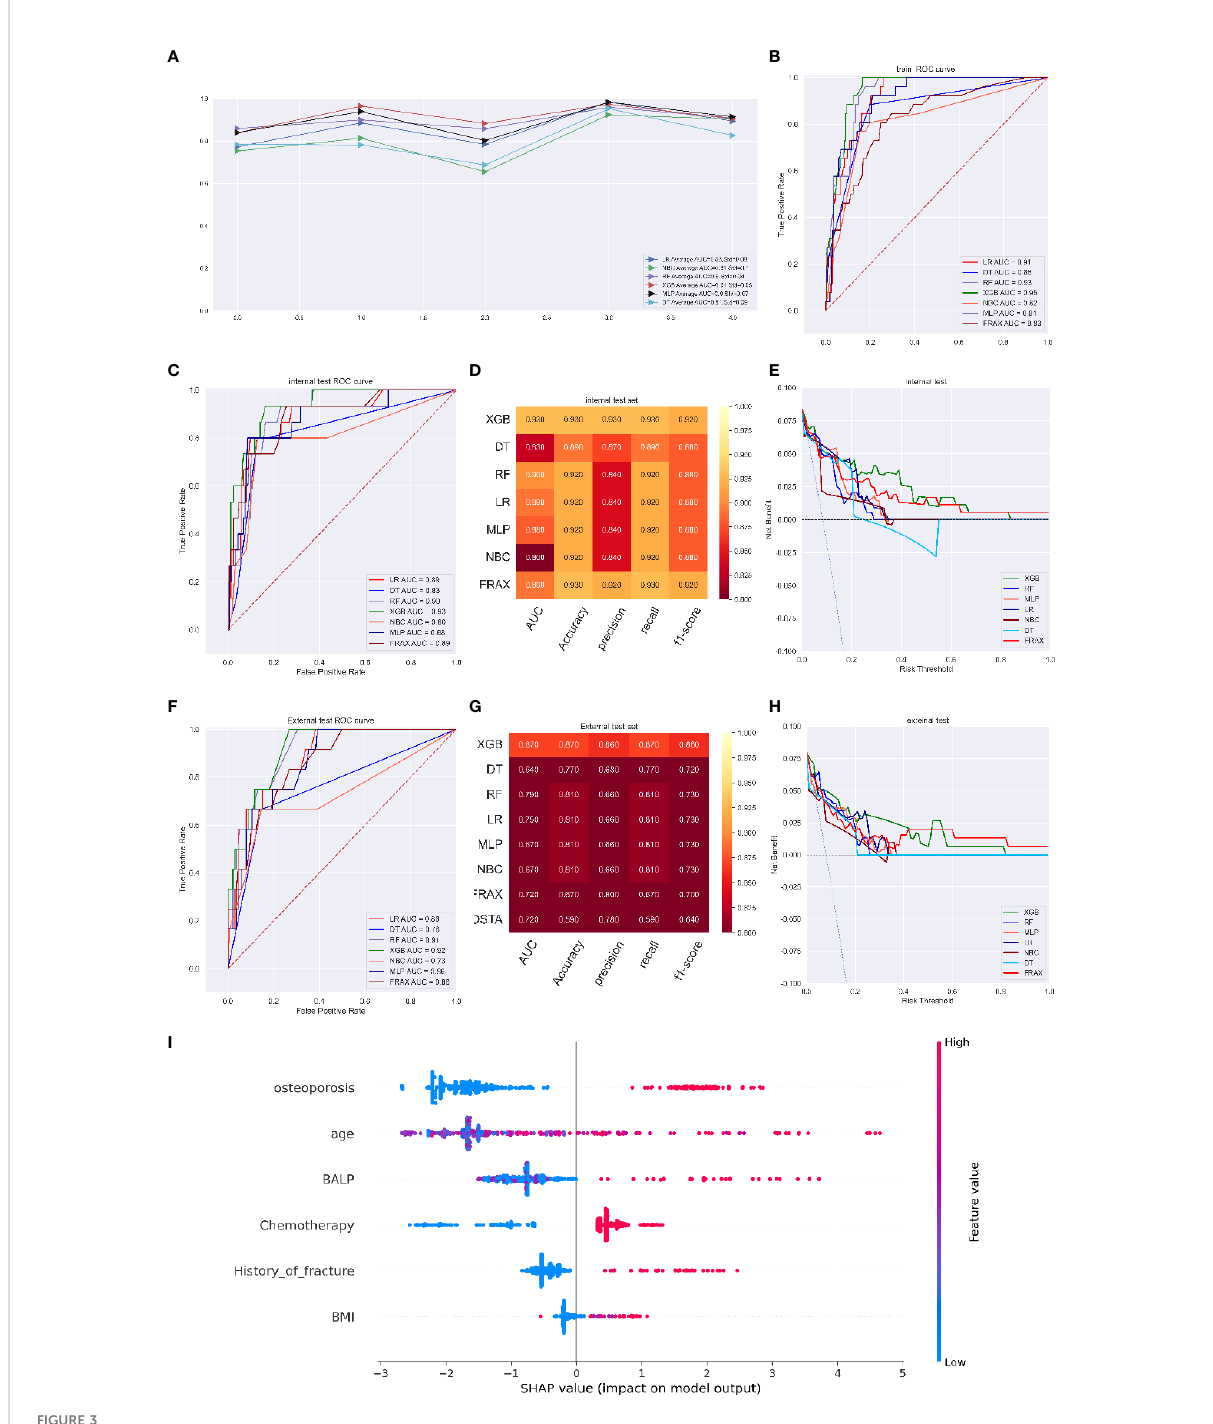
FIGURE 3 (A) Five-fold cross-validation results of different machine models in training set. (B) The ROC curve of different machine learning models, FRAX score in training test set. (C) The ROC curve of different machine learning models, FRAX score in internal test set. (D) Prediction performance of different models, FRAX score in internal test set. (E) The DCA curve of different machine learning models, FRAX score in internal test set. (F) The ROC curve of different machine learning models, FRAX score in external test set. (G) Prediction performance of different models, FRAX score in external test set. (H) The DCA curve of different machine learning models, FRAX score in external test set. (I) Feature importance plot for the XGB osteoporosis prediction model. All the features are shown in this fi gure. The blue and red points in each row represent nodules having low to high values of the speci fi c feature, while the x -axis shows the SHAP value, indicating the impact on the model. (fracture predicting